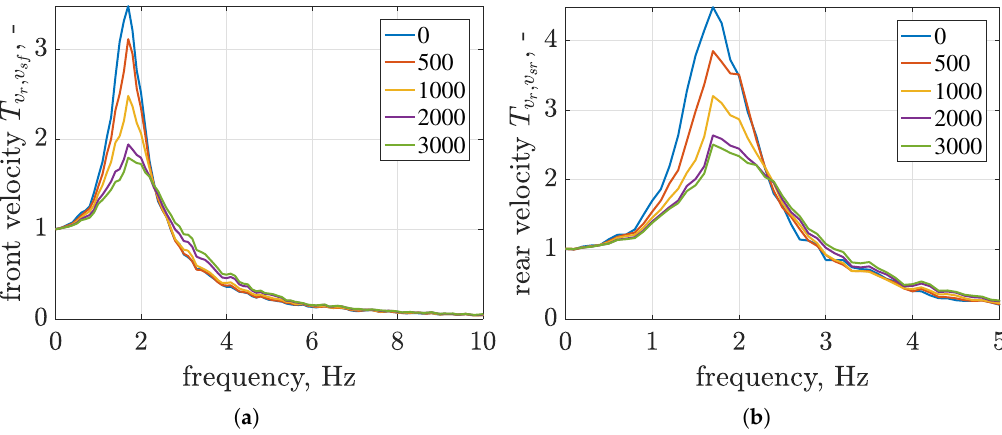
Figure 13. Transmissibility characteristics of vehicle body dynamics for Skyhook control of suspension parts and vehicle longitudinal velocity equal to 5 ms − 1 : ( a ) front body velocity, ( b ) rear body